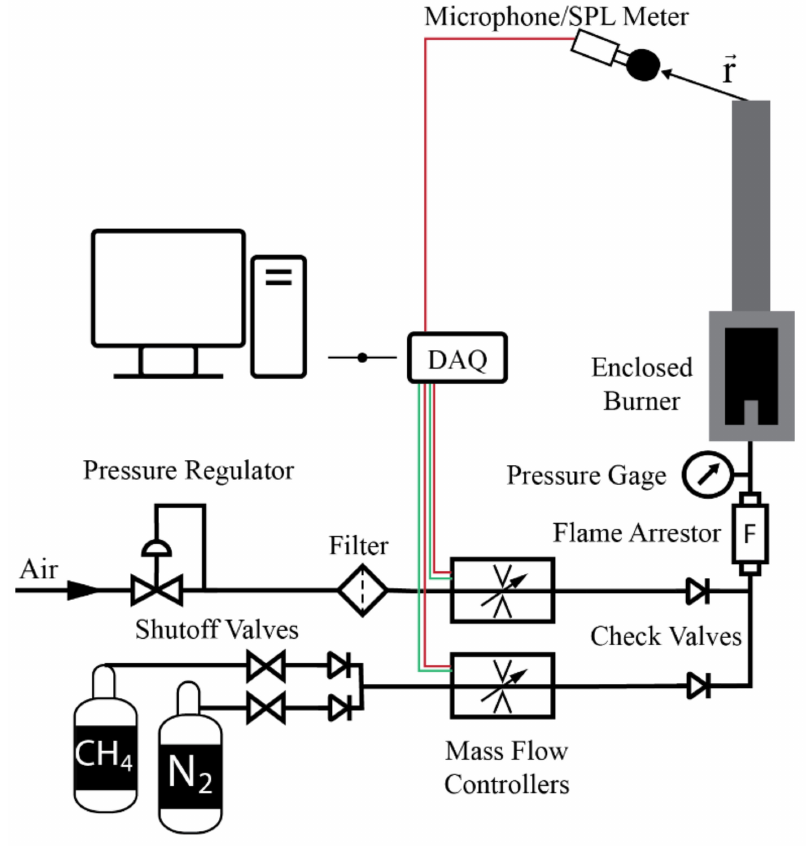
Figure 2. Diagram of the experimental